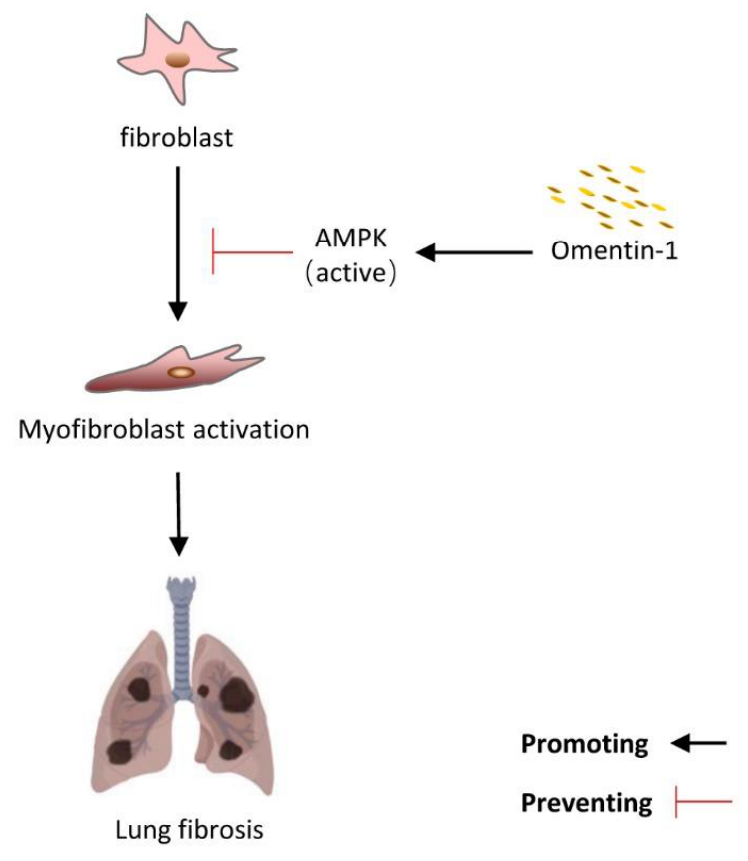
Figure 8. The summary of the effect of omentin-1 in lung fibrosis.